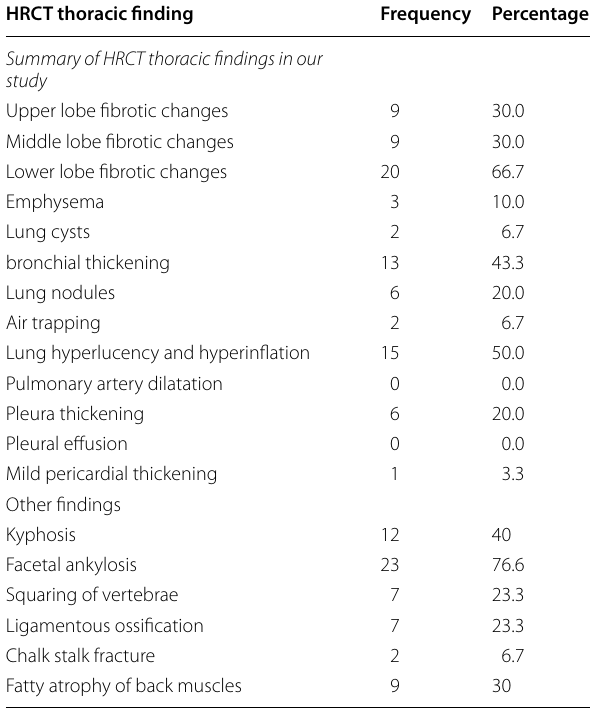
Table 1 Summary (frequency and percentage) of HRCT